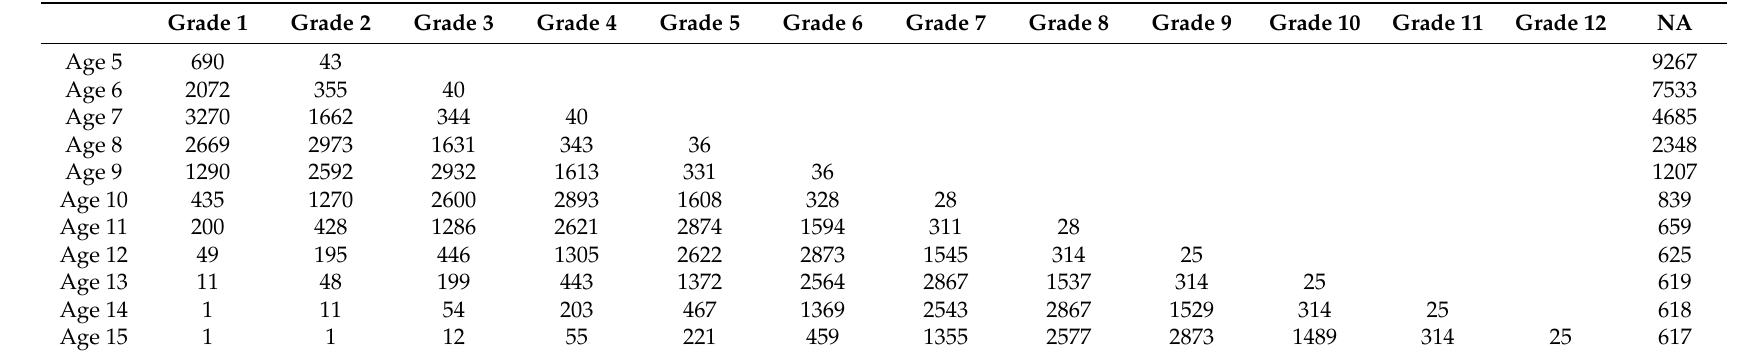
Table A8. Grade transition in unelectrified areas